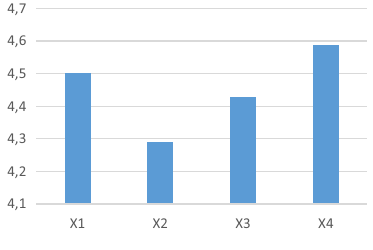
Figure 1. The average score of variable X1-X4 in